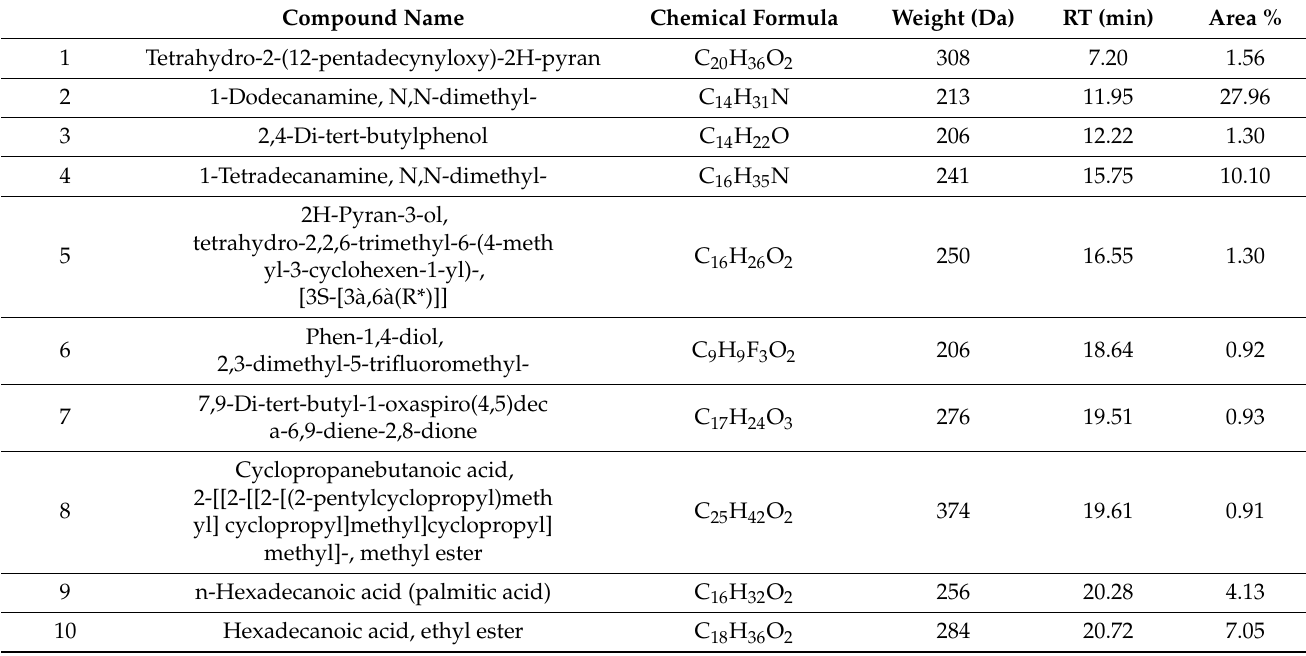
Table 2. The metabolites detected in the non-polar extract of Subramaniula asteroids